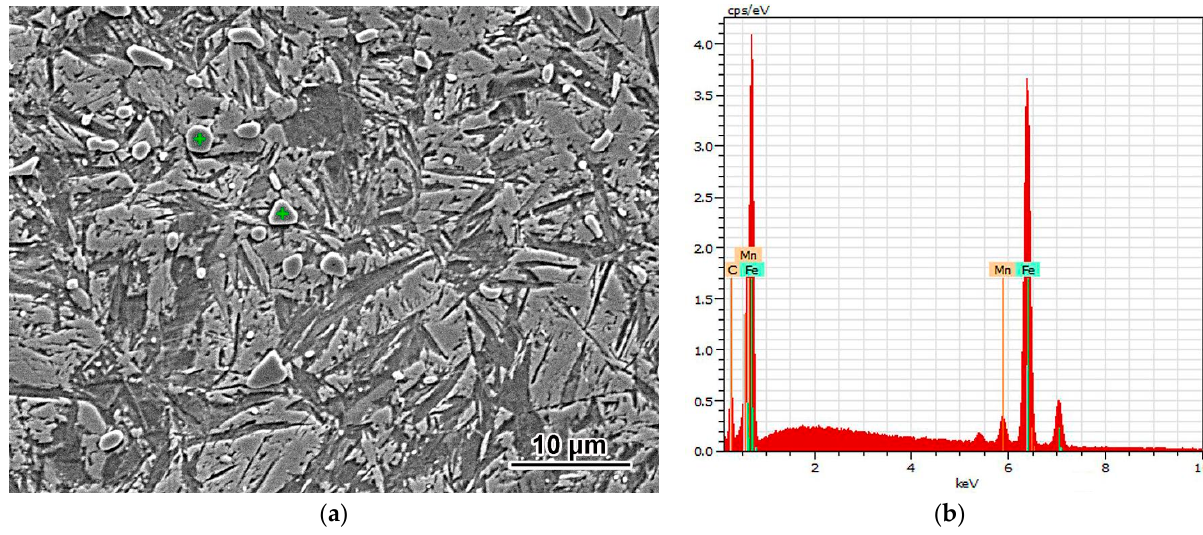
Figure 3. ( a ) The points of EDX analysis and ( b ) corresponding EDX spectrum (900 °C-quenched sample).